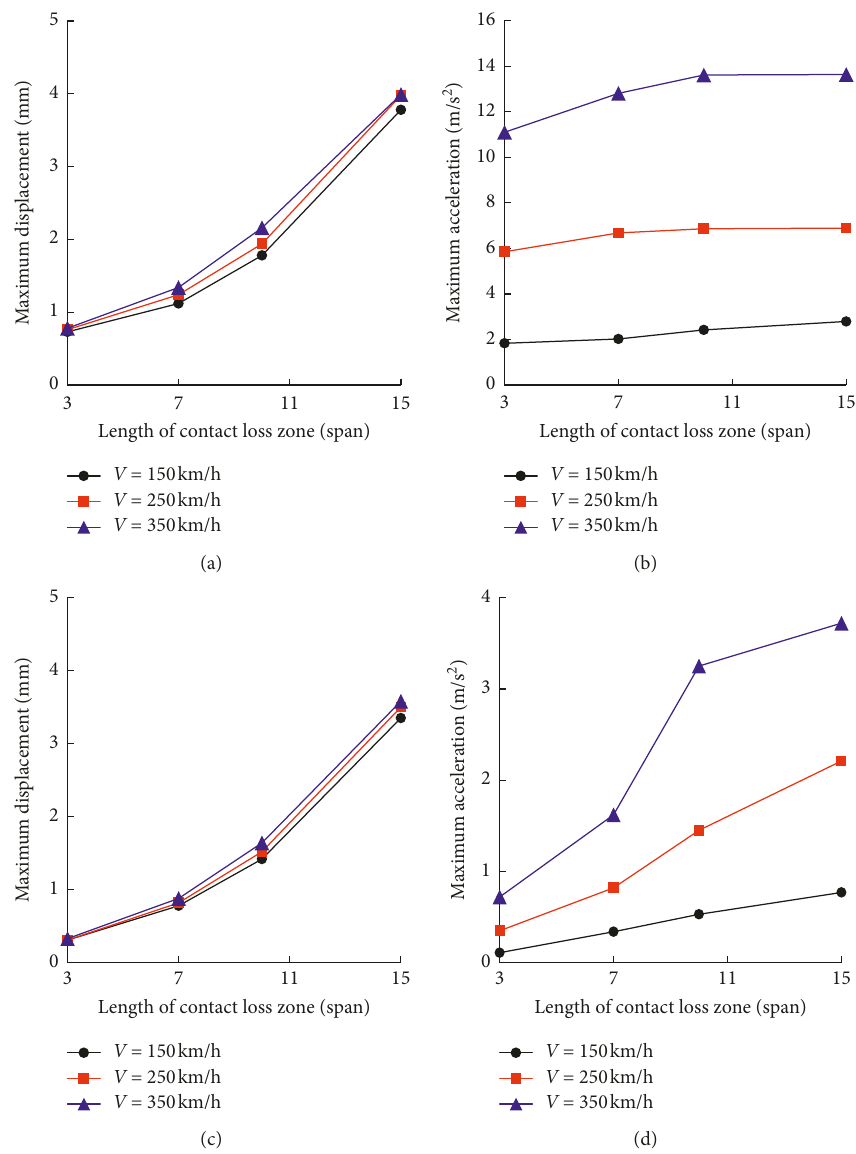
Figure 14: Vibration responses of track subsystem with different lengths of the contact loss zone and rail speeds: (a) dynamic displacement of rail, (b) acceleration of rail, (c) dynamic displacement of concrete base, and (d) acceleration of concrete